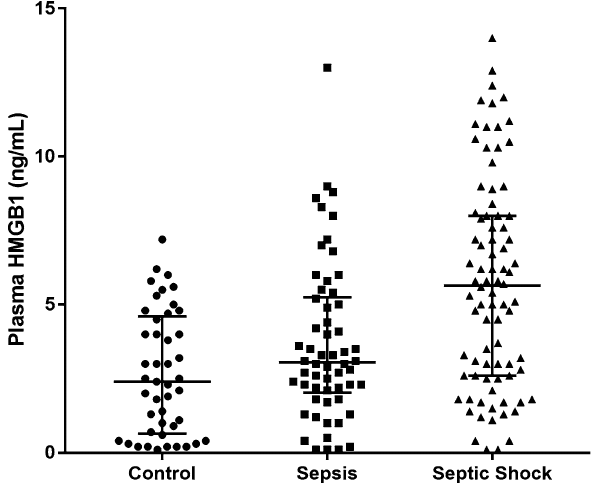
Figure 2. Plasma levels of high-mobility group box-1 (HMGB1) in control, sepsis, and septic shock in the derivation cohort (n = 188) ( P for trend < 0.001). The bars represent median and interquartile